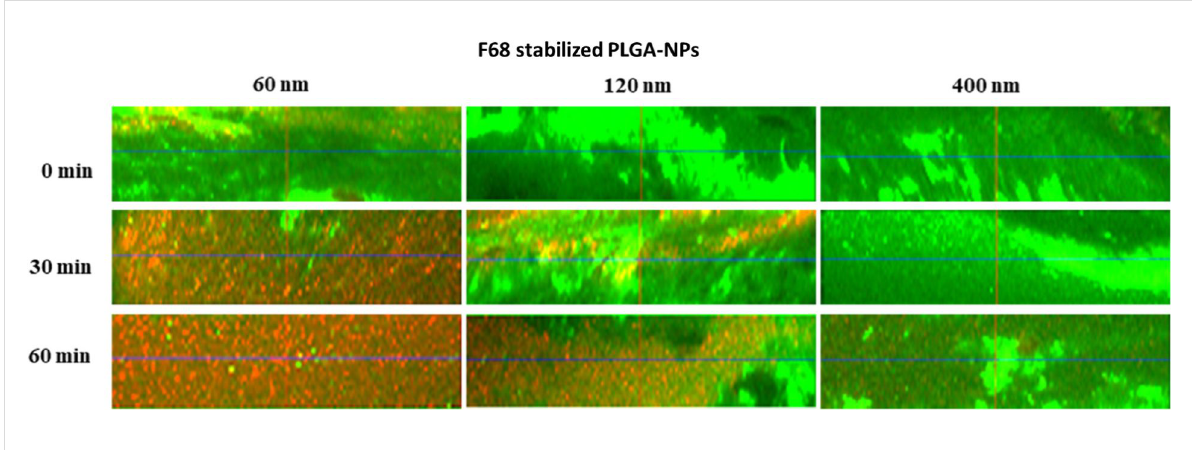
Figure 12: xz -micrographs taken in confocal laser scanning microscopy study of the penetration of differently sized F68-stabilized PLGA NPs. Fluo- rescently labelled (red fluorescence) 60, 120 and 400 nm NPs were imaged along 40 µm of pulmonary human mucus at predetermined time intervals. The mucus was stained with wheat germ agglutinin (green